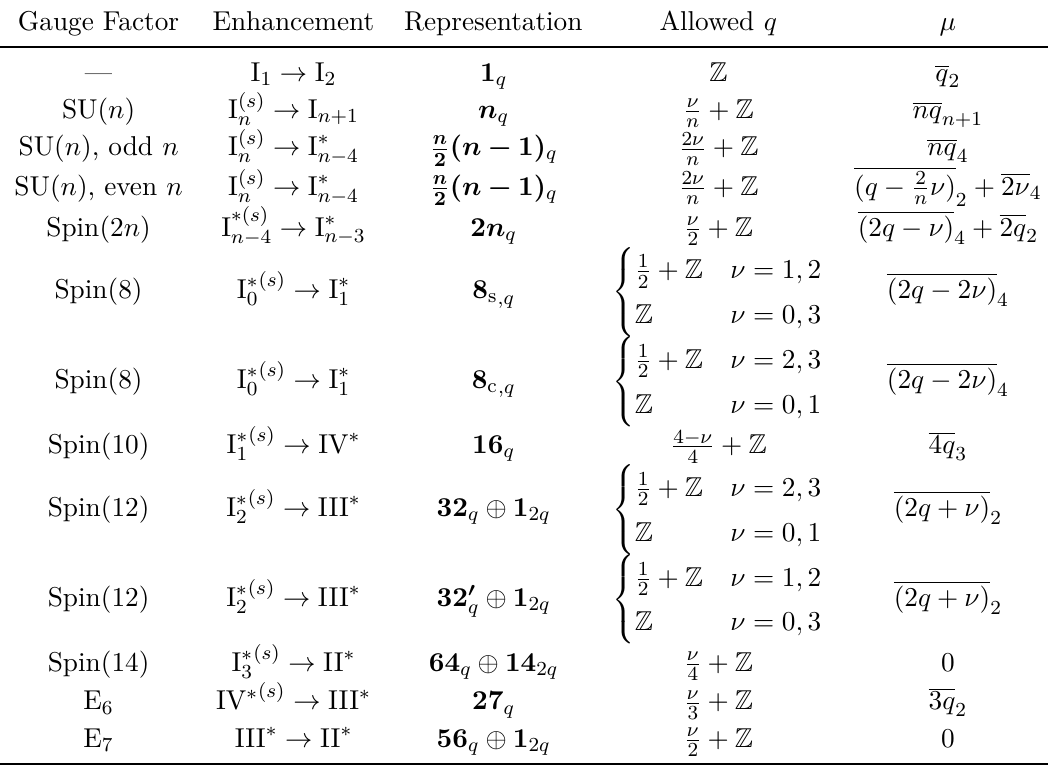
Table 2. Relations between ν , µ , and the u (1) charge q for various representations. Note that, in our conventions, the 32 representation of Spin(12) has highest weight [0 , 0 , 0 , 0 , 0 , 1] , while the 32 0 representation has highest weight [0 , 0 , 0 , 0 , 1 , 0] . This convention differs from [77] but agrees with